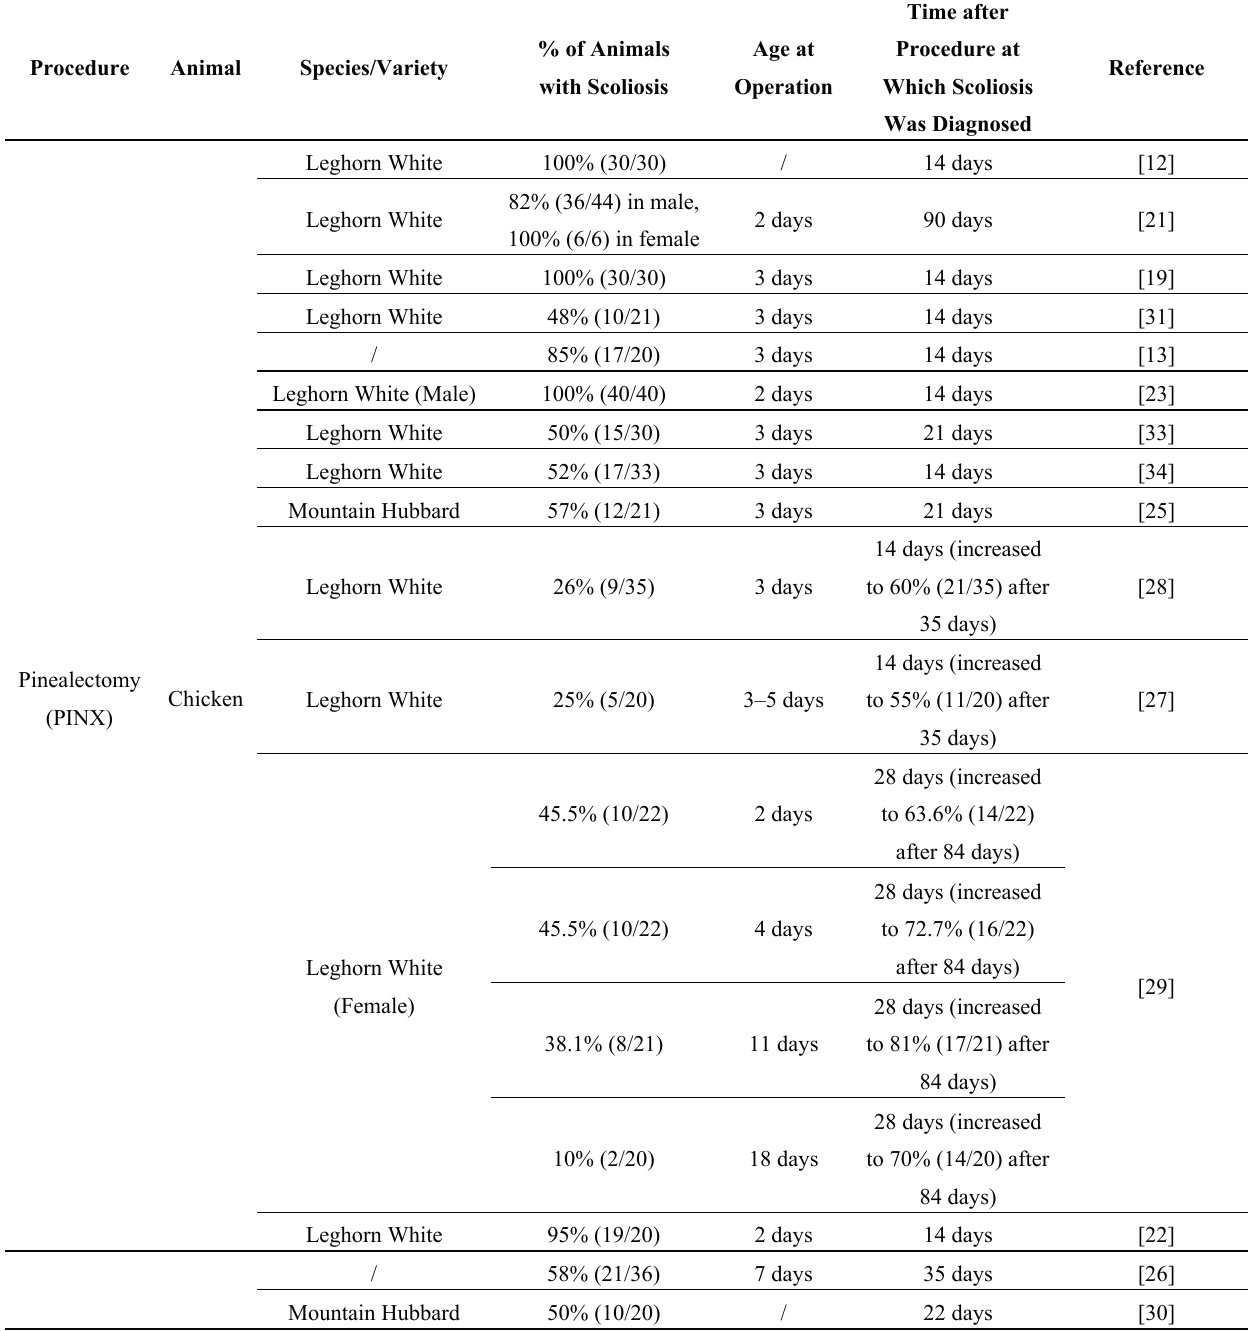
Table 1. Different varieties of melatonin-deficient animal